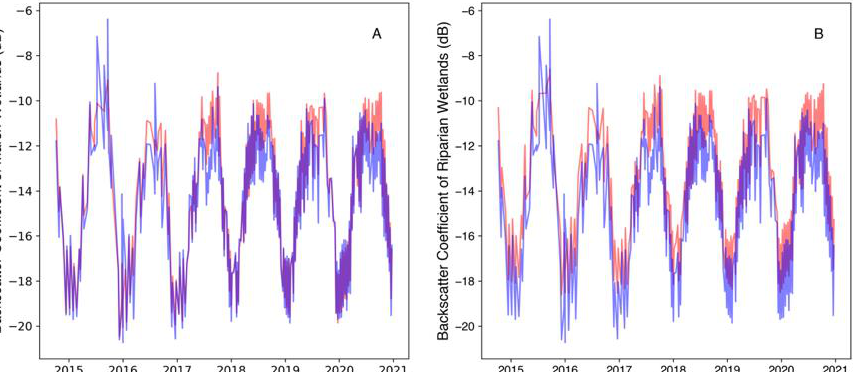
Figure 7. Red: Time series of backscatter coefficients of VV bands averaged over all marsh wetlands ( A ) and riparian wetlands ( B ). Blue: Time series of backscatter coefficients of VV bands averaged over samples of grassland in the study region.